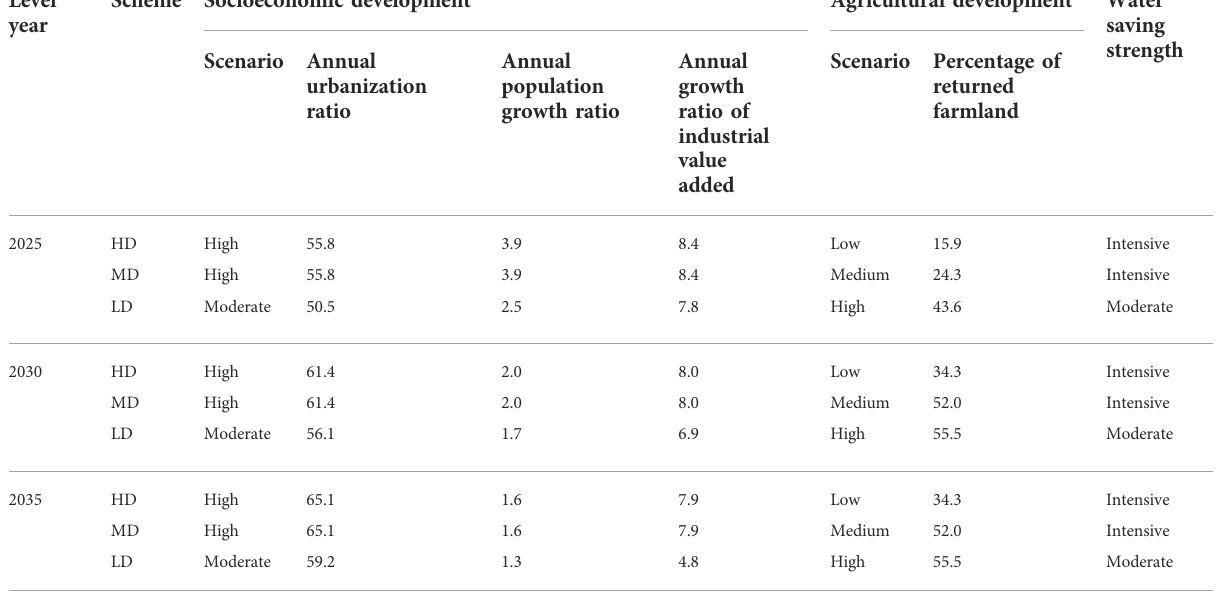
TABLE 1 Water demand scenarios of Jinghe County (amount: 10 6 m 3 , ratio: %).